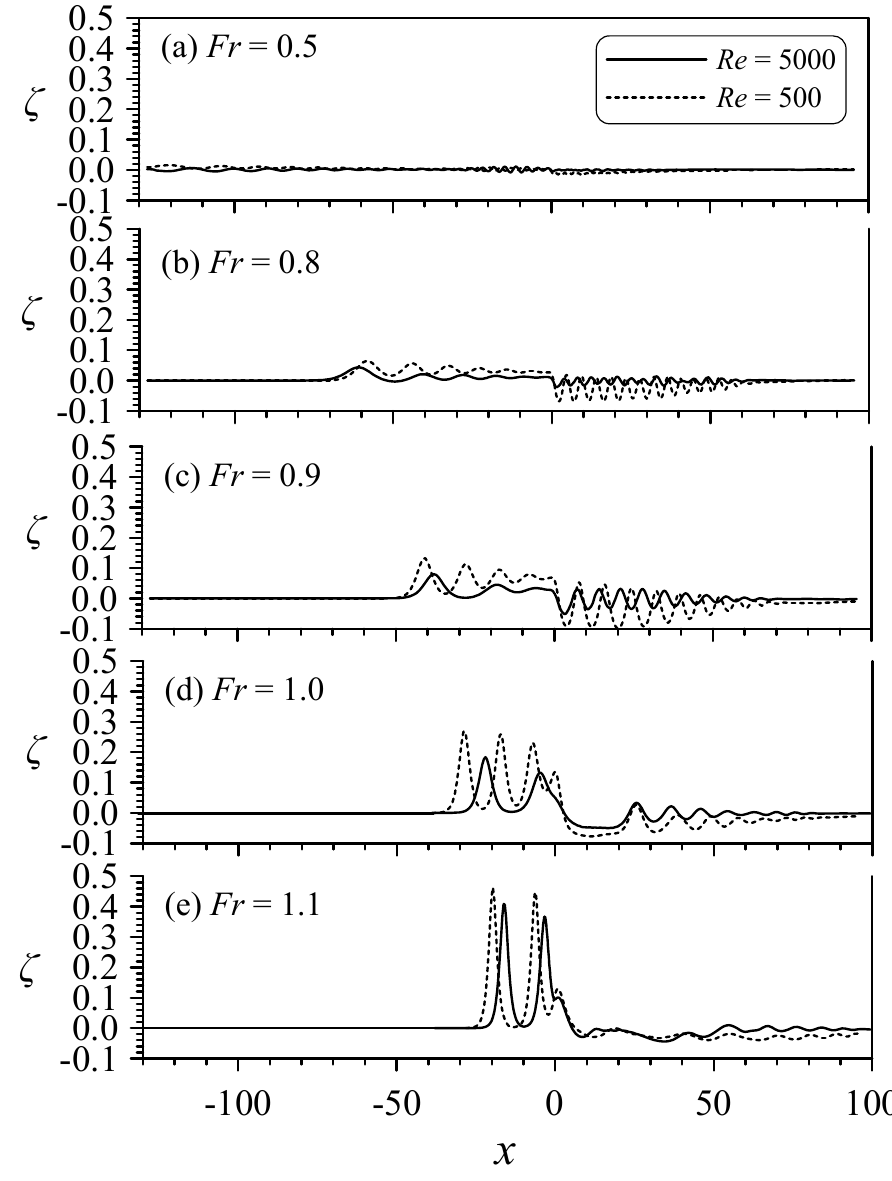
Figure 14. Comparisons of the free-surface profiles at t = 300 for Re = 5000 and 500 with various Fr : ( a ) Fr = 0.5, ( b ) Fr = 0.8, ( c ) Fr = 0.9, ( d ) Fr = 1.0, and ( e ) Fr = 1.1.